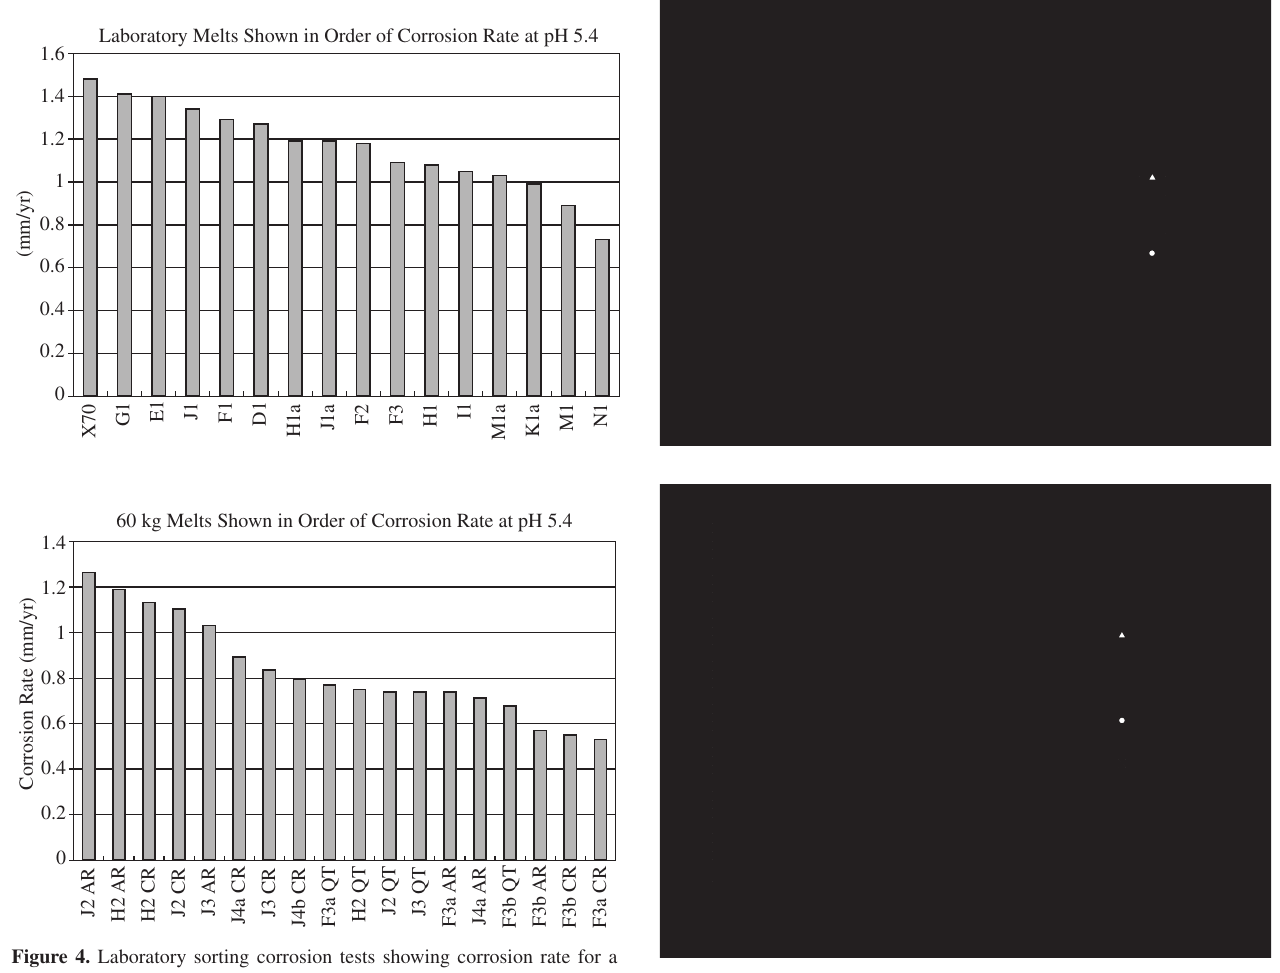
Figure 6. Flow-loop corrosion tests showing corrosion rate as a function of time.